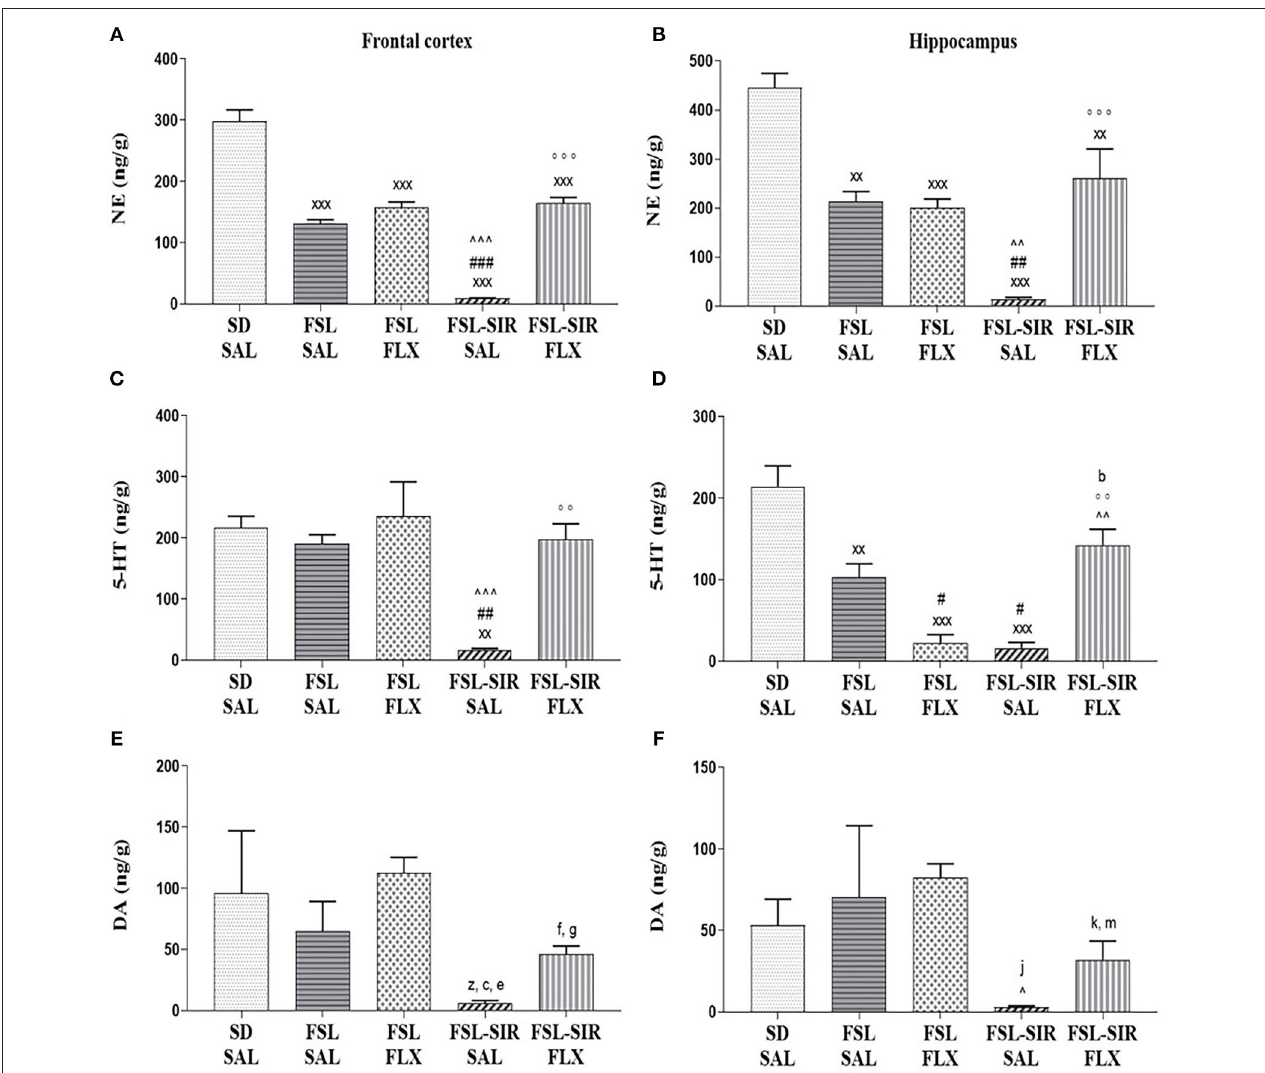
FIGURE 5 | Monoamine levels in the frontal cortex (A,C,E) and hippocampus (B,D,F) . (A) NE. xxx p < 0.0001 vs. SD-SAL; ### p < 0.0001 vs. FSL-SAL; ∧∧∧ p < 0.0001 vs. FSL-FLX; ◦◦◦ p < 0.0001 vs. FSL-SIR-SAL. (B) NE. xxx p < 0.0001, xx p < 0.01 vs. SD-SAL; ## p < 0.01 vs. FSL-SAL; ∧∧ p < 0.01 vs. FSL-FLX; ◦◦◦ p < 0.0001 vs. FSL-SIR-SAL. (C) 5-HT. xx p < 0.01 vs. SD-SAL; ## p < 0.01 vs. FSL-SAL; ∧∧∧ p < 0.0001 vs. FSL-FLX; ◦◦ p < 0.01 vs. FSL-SIR-SAL. (D) 5-HT. xxx p < 0.0001, xx p < 0.01 vs. SD-SAL; # p < 0.05 vs. FSL-SAL; ∧∧ p < 0.01 vs. FSL-FLX, ◦◦ p < 0.01 vs. FSL-SIR-SAL. b d = 1.0 vs. SD-SAL. (E) DA. z d = 0.8 vs. SD-SAL; c d = 1.0 vs. FSL-SAL, e d = 3.5, f d = 2.0 vs. FSL-FLX, g d = 2.4 vs. FSL-SIR-SAL. (F) DA. ∧ p < 0.05 vs. FSL-FLX. j d = 1.3 vs. SD-SAL, k d = 1.5 vs. FSL-FLX; m d = 1.1 vs. FSL-SIR-SAL. Data were analysed using two-way ANOVA followed by Bonferroni post hoc test and Cohen’s d analysis. Data are presented as mean ± SEM. Detailed p –values in the text. DA, dopamine; FSL, Flinders’ Sensitive Line; FLX, fluoxetine; NE, norepinephrine; SAL, saline; 5-HT, serotonin; SIR, social isolation rearing; SD, Sprague-Dawley.